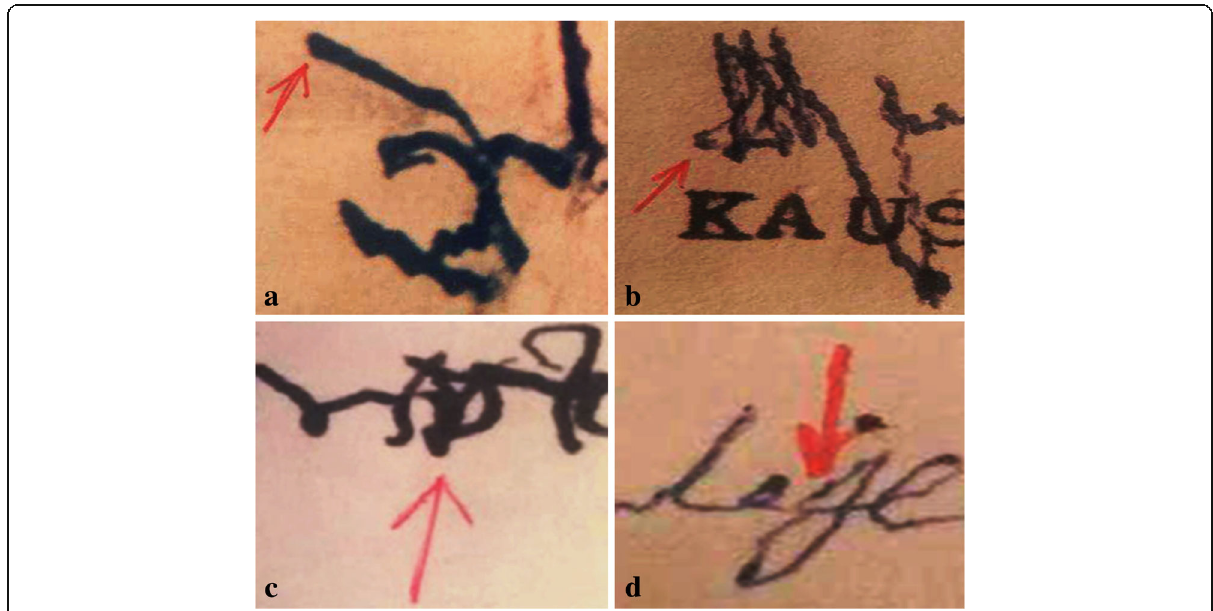
Fig. 4 Initial, terminal, and connecting strokes. a Signatures of an aged subject showing peculiar wedge shaped initial strokes. b Signatures of a